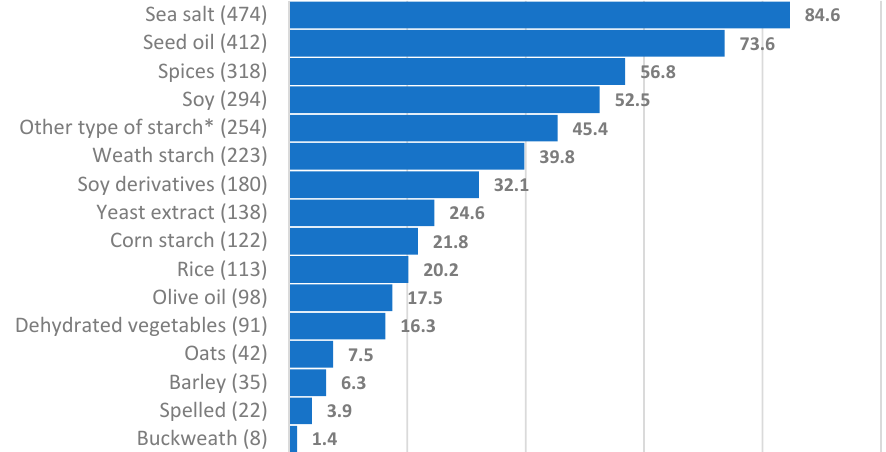
Figure 2. Ingredient prevalence expressed as percentage of products in which an ingredient appears. * Potato, tapioca, pea, starches, and modified starches (additive E1401), used as a thickener and as a stabilizer. Data represent the frequency with which an ingredient appears in the analyzed products. The total number of analyzed products per category is reported in brackets.